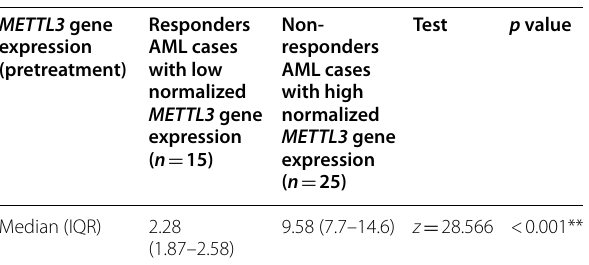
Table 4 Comparison between the two AML subgroups